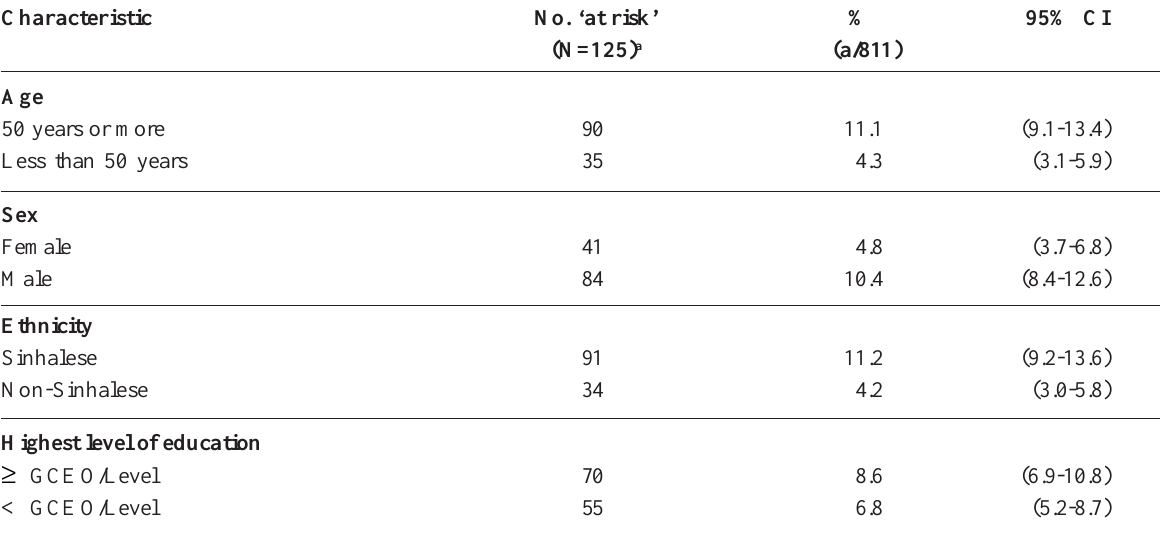
Table 5. Prevalence of those ‘at risk’ for developing colorectal cancer among the